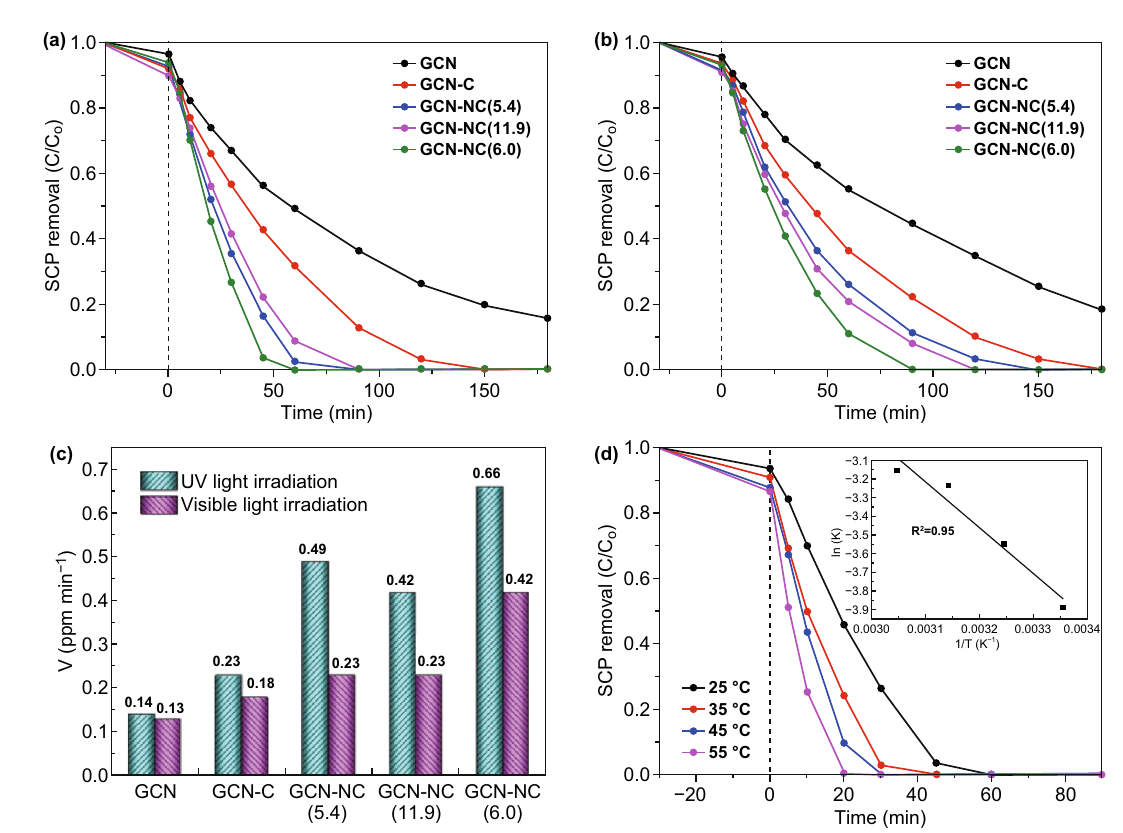
Fig. 4 a Photocatalytic degradation of SCP over GCN, GCN-C, GCN-NC(5.4), GCN-NC(11.9), and GCN-NC(6.0) under UV light irradia- tion and b under visible light irradiation. c Comparison of the degradation rate constants of GCN, GCN-C, GCN-NC(5.4), GCN-NC(11.9), and GCN-NC(6.0) photocatalysts under UV and visible light irradiations. d The effect of temperature on degradation over